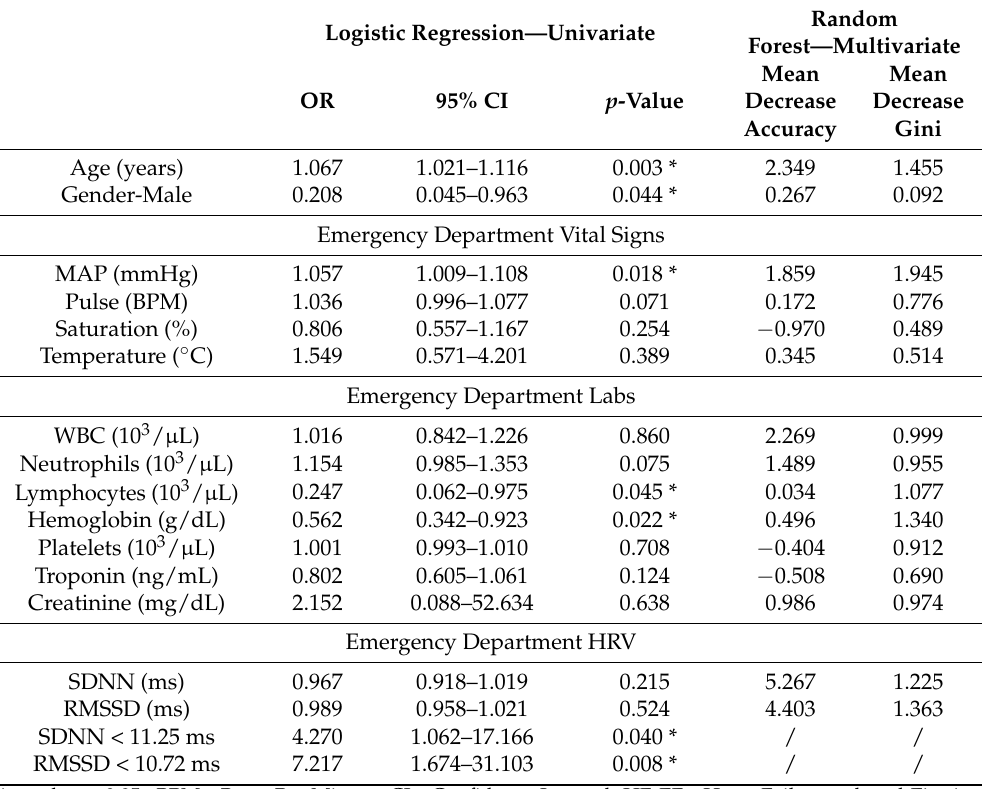
Table 3. Composite outcome of severe short-term disease-specific complications (in-hospital mortal- ity/VA/new severe HFrEF)—logistic regression and random forest classifiers. Random Logistic Regression—Univariate Forest—Multivariate OR